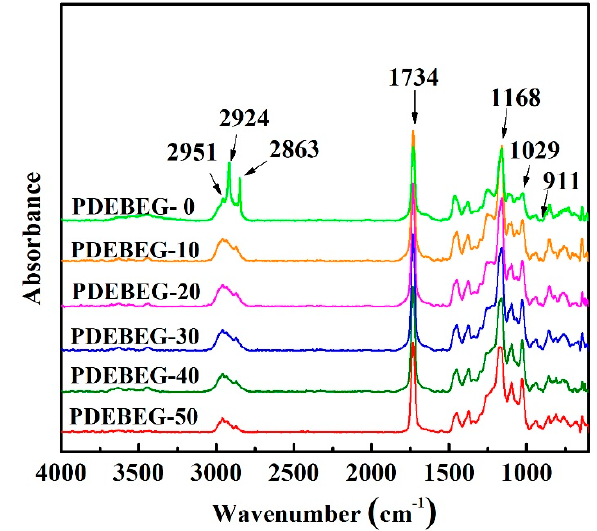
Figure 3. FT-IR spectra of PDEBEG.